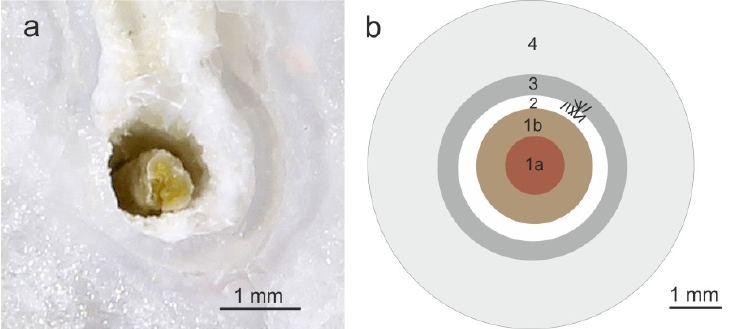
Figure 22. ( a ) Cross-section of sample Jal 11 and ( b ) schematic microstructure of SFF Ir : 1a = filamentous core (Fe-rich sheet silicates), 1b = outer part of the filament core (Fe-containing sheet silicates), 2 = surrounding zone of an empty tube (partially containing fibrous zeolite, e.g., mordenite), 3 = zeolite zone, 4 = marginal zone consisting of a 0.5–20 mm thick zone of silica minerals.